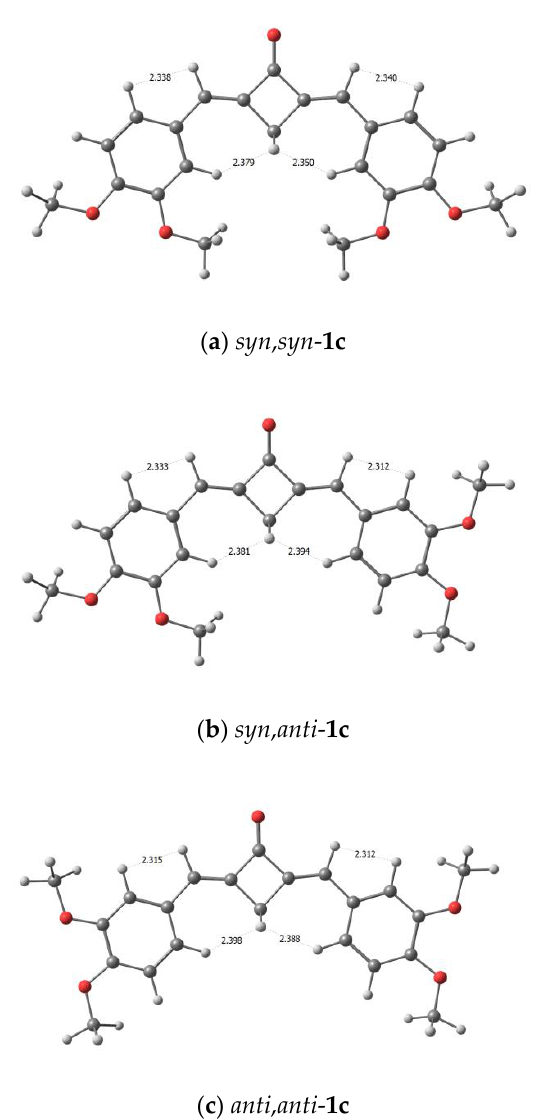
Figure 7. Calculated distances between the protons in the syn,syn- 1c ( a ), syn,anti- 1c ( b ), and anti,anti- 1c ( c ).